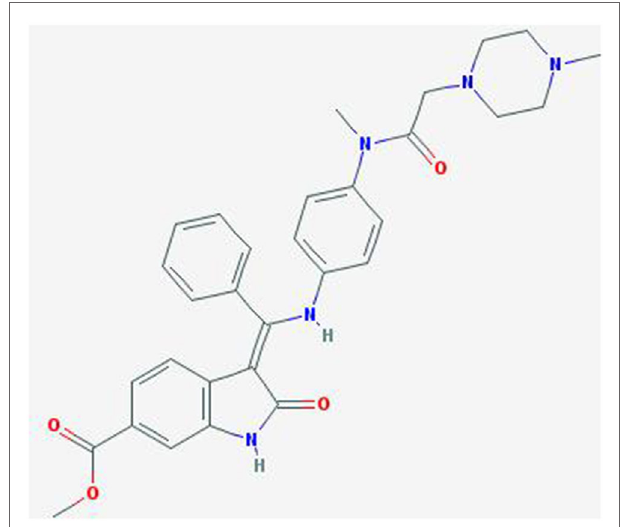
FiGURe 1 | Chemical structure of Nintedanib